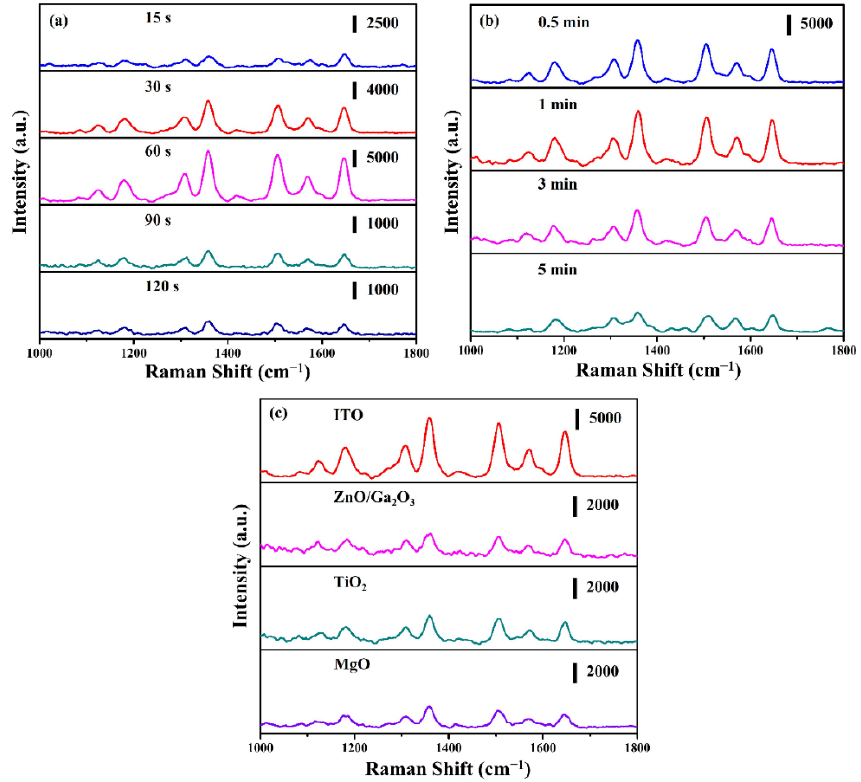
Figure 6. ( a ) SERS spectra of (10 − 6 M) R6G solution on ZnO: Ga@Ag nanotowers fabricated at differ- ent Ag ion-sputtering times. ( b ) SERS spectra of (10 − 6 M) R6G solution on ZnO: Ga@ITO@Ag nano- towers fabricated at different ITO ion-sputtering times. ( c ) SERS spectra of (10 − 6 M) R6G solution on the different materials for the intermediate layer between ZnO: Ga nanotowers and Ag nanoparti- cles.